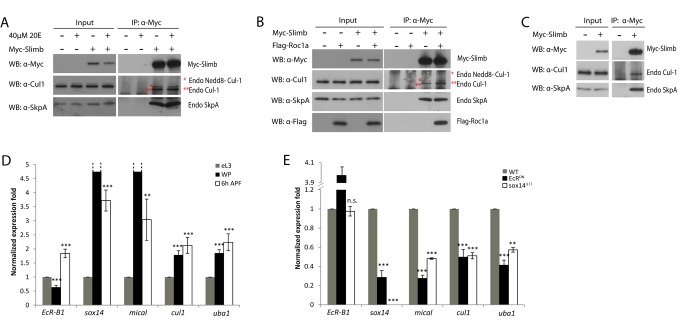
The Cul1-based SCF E3 ligase components interact with each other and cul1 expression is dependent on EcR-B1 and Sox14.(A) Endogenous SkpA and Cul1 associated with Slimb in an ecdysone-independent manner. Nontreated (−) and ecdysone-treated S2 cells were transfected with Myc-Slimb. (B) Roc1a and Slimb associated in a complex with Cul1 and SkpA in S2 cells co-transfected with Myc-Slimb and Flag-Roc1a. (C) Endogenous SkpA and Cul1 co-immunoprecipitated with Myc-Slimb in the protein extracts from the wandering larval brains. (D) Expression profile of EcR-B1, sox14, mical, cul1, and uba1 in the MB γ neurons at eL3, WP, and 6 h APF. mRNA level of cul1, like sox14, mical, and uba1, was upregulated upon white prepupal formation. (E) Expression profile of EcR-B1, sox14, mical, cul1, and uba1 in MB γ neurons from wild-type or mutant animals at 6 h APF. mRNA level of cul1 was significantly reduced in EcRDN expressing or sox14Δ13 mutant MB γ neurons. **p<0.01, ***p<0.001, n.s., not significant. See genotypes in Text S1.